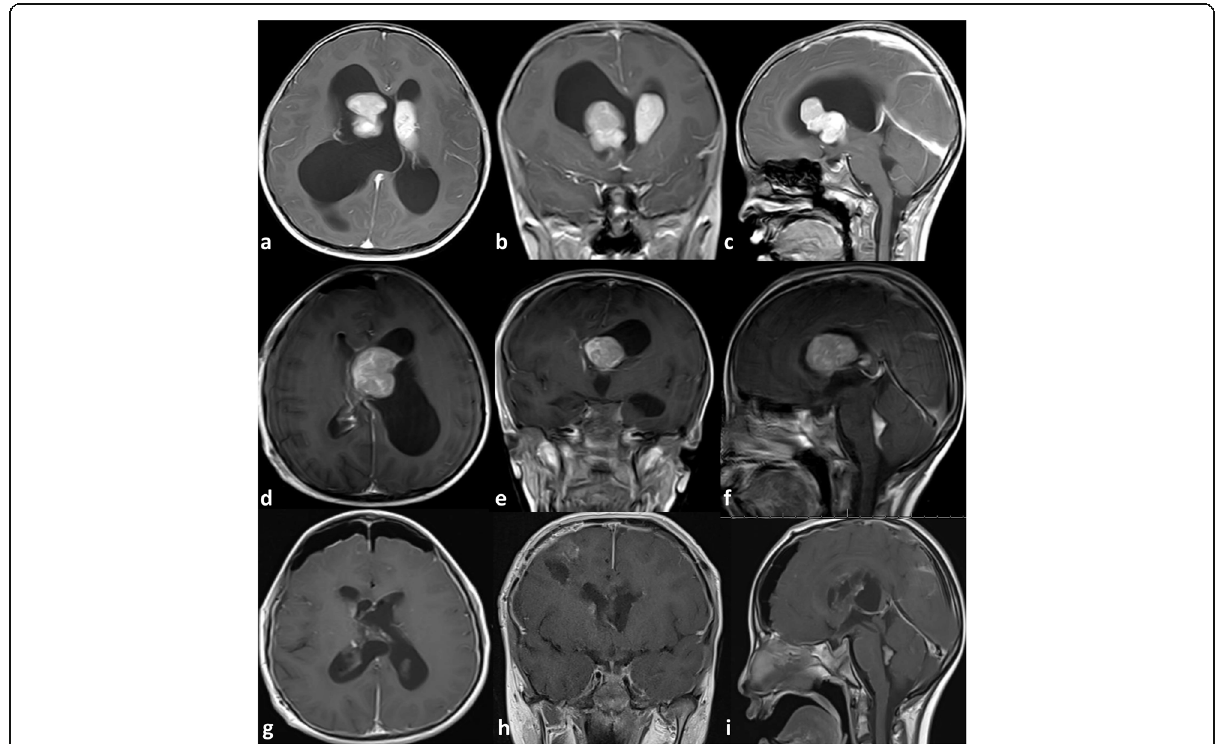
Fig. 2 Bilateral intraventricular sub-ependymal giant cell astrocytoma in an 8-year-old boy, who had generalized tonic-clonic convulsions. The patient had undergone an endoscopic biopsy and ventriculoperitoneal shunting, after which the seizures were controllable with medical treatment, and a decision of conservative management and serial follow-up imaging was taken. On 6-month follow-up, the seizures recurred and were difficult to control, and both tumors proved to have enlarged in size especially the right sided tumor. The right-sided tumor was surgically excised first through a right frontal trans-cortical approach, then the left-sided tumor was surgically excised in another session through a left frontal transcortical approach. a – c The initial axial, coronal, and sagittal contrast-enhanced brain MRI study. d – f Post-operative MRI following the first surgical session after excision of the right sided tumor which had enlarged during a 6-month follow-up period. g – i The final postoperative axial, coronal, and sagittal contrast-enhanced brain MRI study, which demonstrates total excision of both tumors. No CSF diversion was needed in this patient